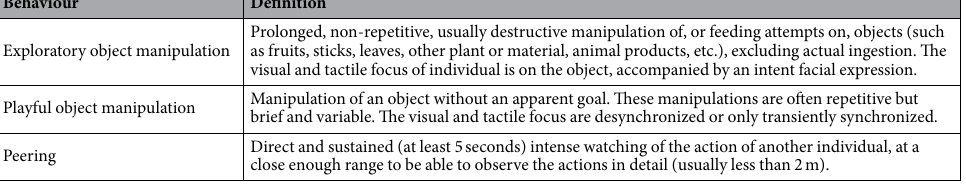
Table 1. Definitions and classifications of the focal